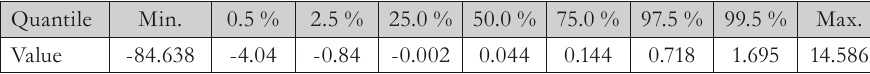
Tab. 4 – Table of the quantile values: ROE. Source: Own investigation.